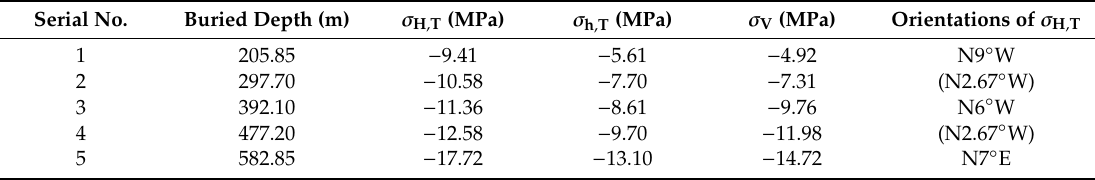
Table 2. The measured in situ stresses of rock masses in the DK-SZLSD-2 borehole [30]. Serial No. Buried Depth